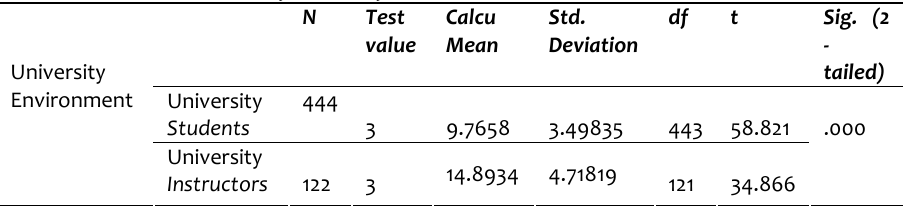
Table 3: The State of University Classroom Environment as